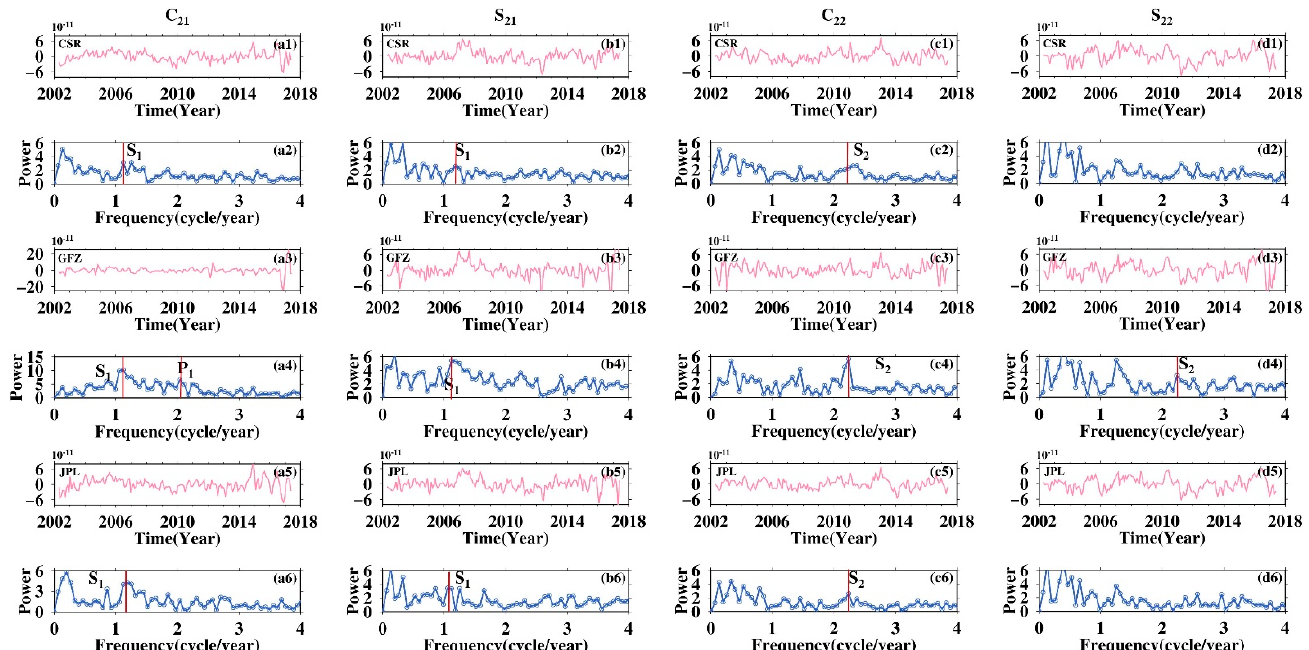
Figure 1. Time series of the non-secular, non-seasonal GRACE low Stokes coefficients and their con- ventional discrete Fourier spectrum. ( a1 , a3 , a5 ) C 21 time series from CSR, GFZ, and JPL, respectively, and ( a2 , a4 , a6 ) are their corresponding Fourier spectra; ( b1 – b6 ) C 21 time series from CSR, GFZ, and JPL, respectively, and ( a1 – a6 ) are their corresponding Fourier spectra for S 21 ; ( c1 – c6 ) C 21 time series from CSR, GFZ, and JPL, respectively, and ( a1 – a6 ) are their corresponding Fourier spectra for C 22 ; ( d1 – d6 ) C 21 time series from CSR, GFZ, and JPL, respectively, and ( a1 – a6 ) are their corresponding Fourier spectra for S 22 .